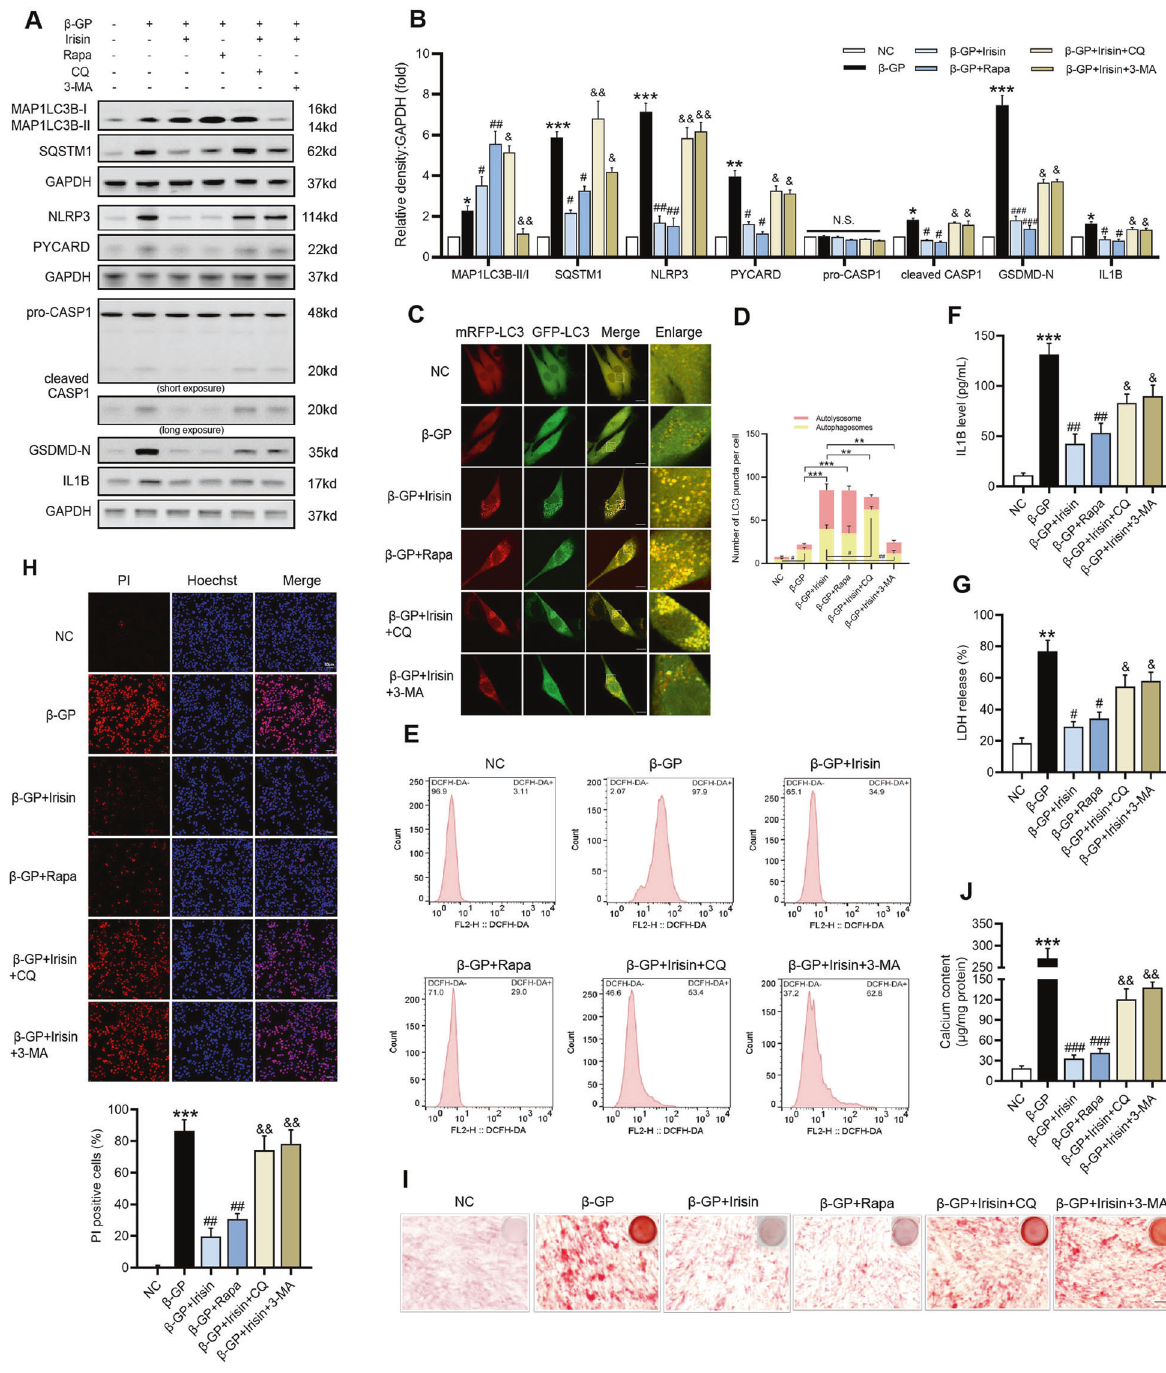
Fig. 6 Irisin protects VSMCs from β -GP-induced pyroptotic cell death and calci fi cation by promoting autophagic fl ux. VSMCs were cultured in the presence of β -GP (10 mM) with or without of Irisin, and were subsequently treated with rapamycin (Rapa, 200 nM), 3-methyladenine (3-MA, 5 mM) or chloroquine (CQ,25 µM) for 72 h (autophagy) or 7 days (calci fi cation). A The protein levels of autophagy- and pyroptosis-related markers were determined by western blotting. B Quanti fi cation of the results shown in A. C Confocal microscopy observation of mRFP-GFP-LC3 adenovirus transfected VSMCs treated as indicated (Magni fi cation: ×63, Scale bars = 10 μ m). D Autophagosome (yellow dots) and autolysosome (red dots) numbers in each group were calculated. Data are expressed as mean ± SEM. *P < 0.05, **P < 0.01, ***P < 0.001 vs. indicated group; # P < 0.05, ## P < 0.01 vs. indicated group. E The intracellular ROS level was detected using the fl uorescent probe DCFH-DA and measured by fl ow cytometry. F The IL1B content in VSMC culture supernatants was determined by ELISA. G The release of LDH was detected using the LDH Assay Kit. H The percentage of PI-positive cells was measured using Hoechst 33342 (blue)/PI (red) double staining (top: Representative images; bottom: Quantitative analysis of PI-positive cells). Scale bar = 50 μ m. I Calcium deposition in VSMCs was assessed by Alizarin red staining. Scale bar = 100 μ m. J Quantitative analysis of calcium deposition in VSMCs normalized to the protein content. Data are expressed as mean ± SEM. *P < 0.05, **P < 0.01, ***P < 0.001 vs. control group; # P < 0.05, ## P < 0.01, ### P < 0.001 vs. corresponding β -GP group; & P < 0.05, && P < 0.01 vs. corresponding β -GP + Irisin group; and N.S. not signi fi